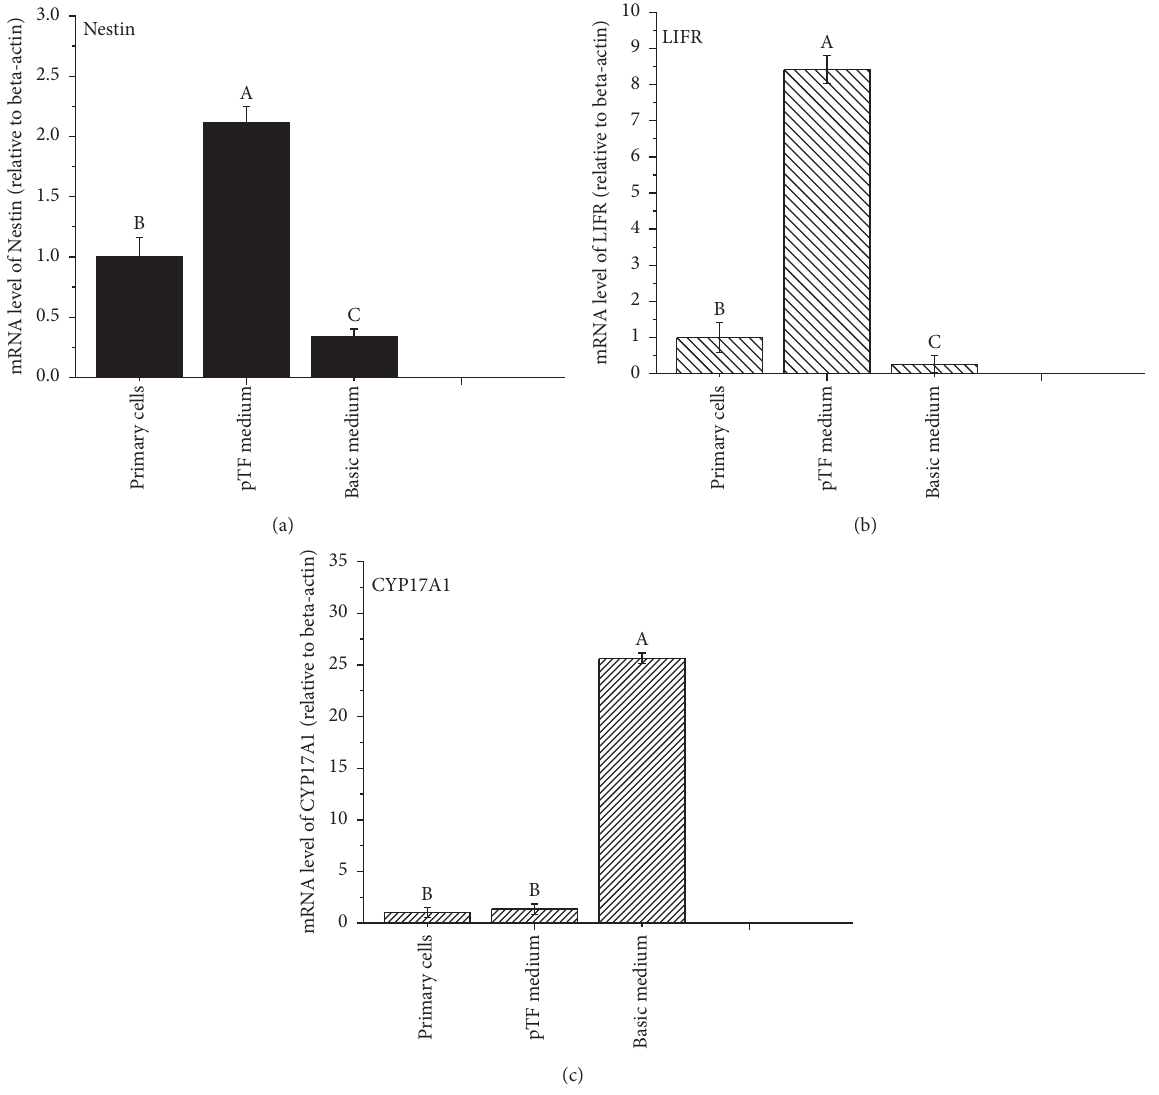
Figure 5: Expressions of Nestin , LIFR, and CYP17A1 of porcine SLCs cultured in different media for 2 w. Note: primary cells, the primary isolated porcine SLCs. Different letters (A, B, C) indicate significant difference ( 𝑃 < 0.05